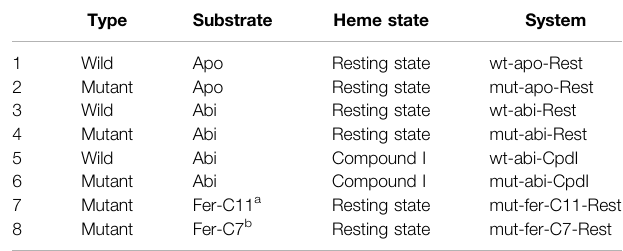
TABLE 1 | Illustration of simulation